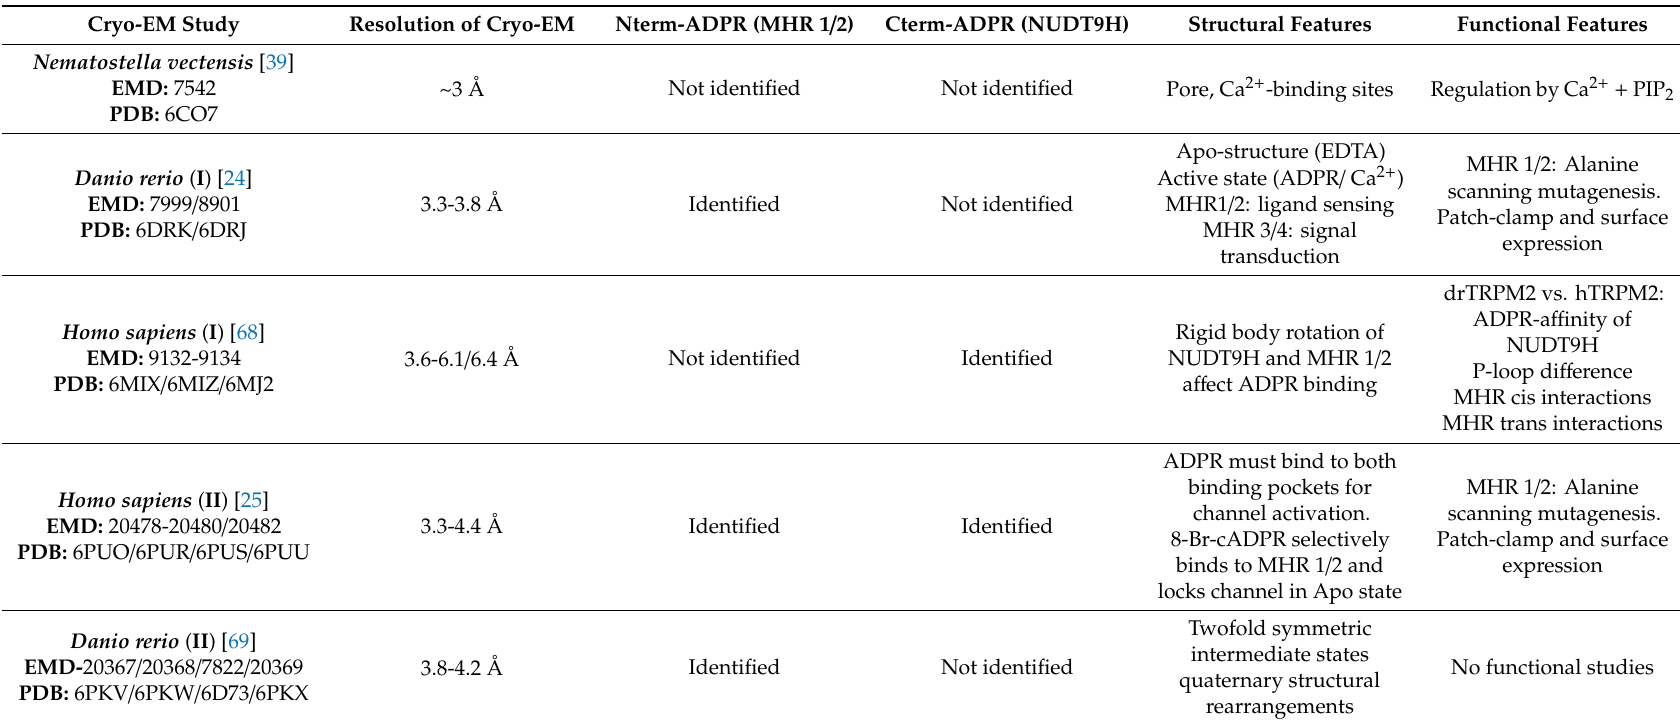
Table 1. Overview of the currently available cryo-EM (cryogenic electron microscopy) data of di ff erent species variants of the TRPM2 channel. This includes the respective structure resolutions, the verification of the N-terminal or C-terminal ADPR (ADP-ribose) binding sites, as well as the main structural and functional